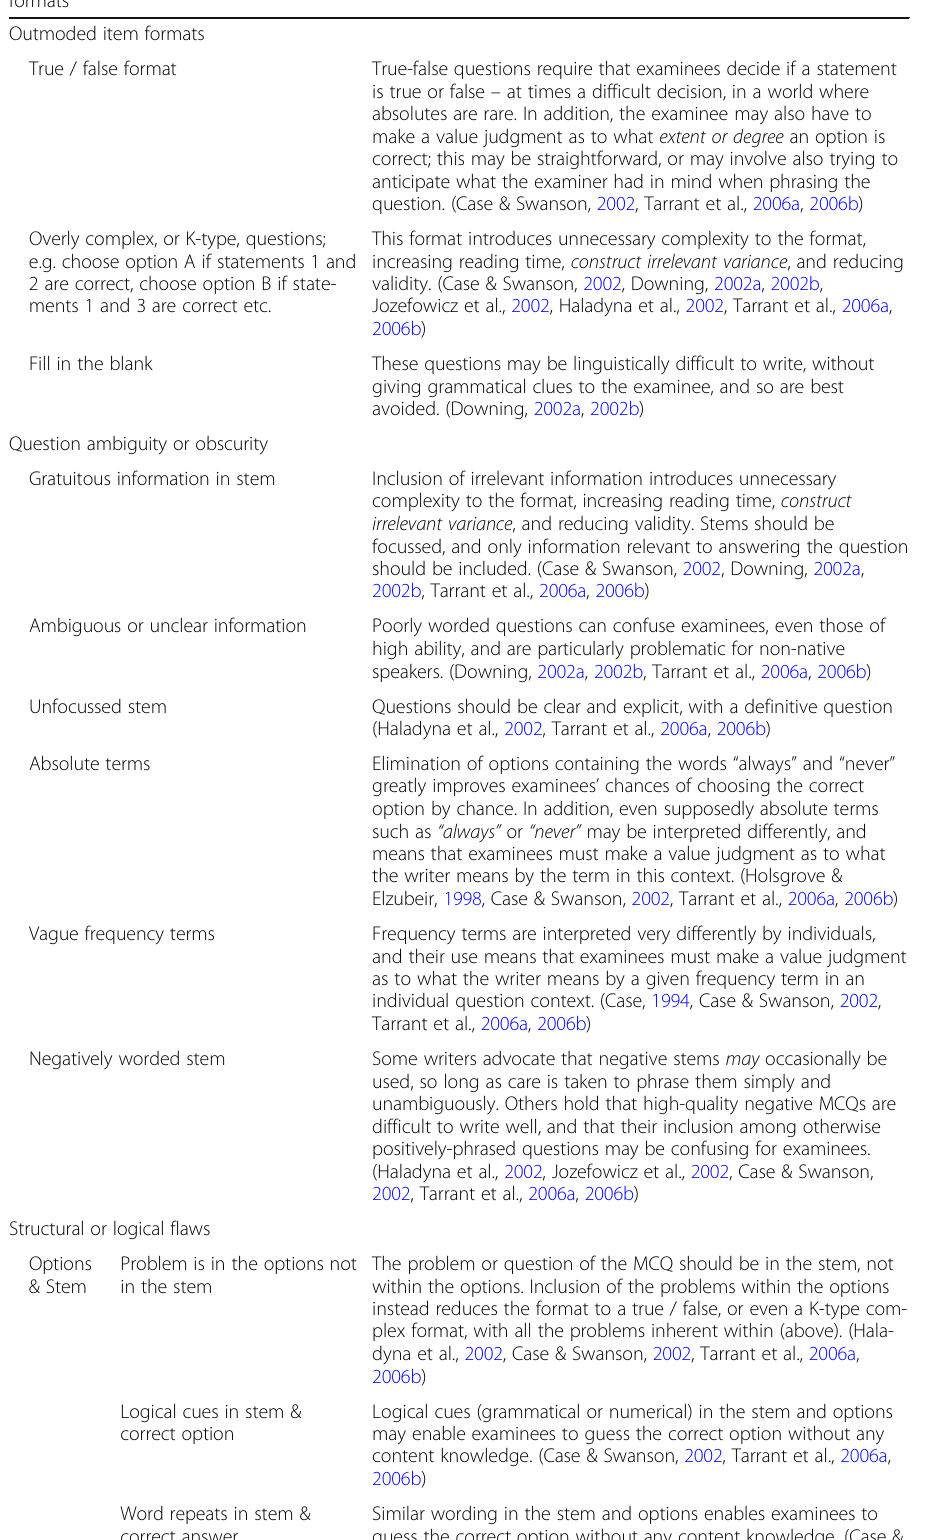
Table 1 Framework of item flaws and their potential effect Technical item flaws or unadvisable